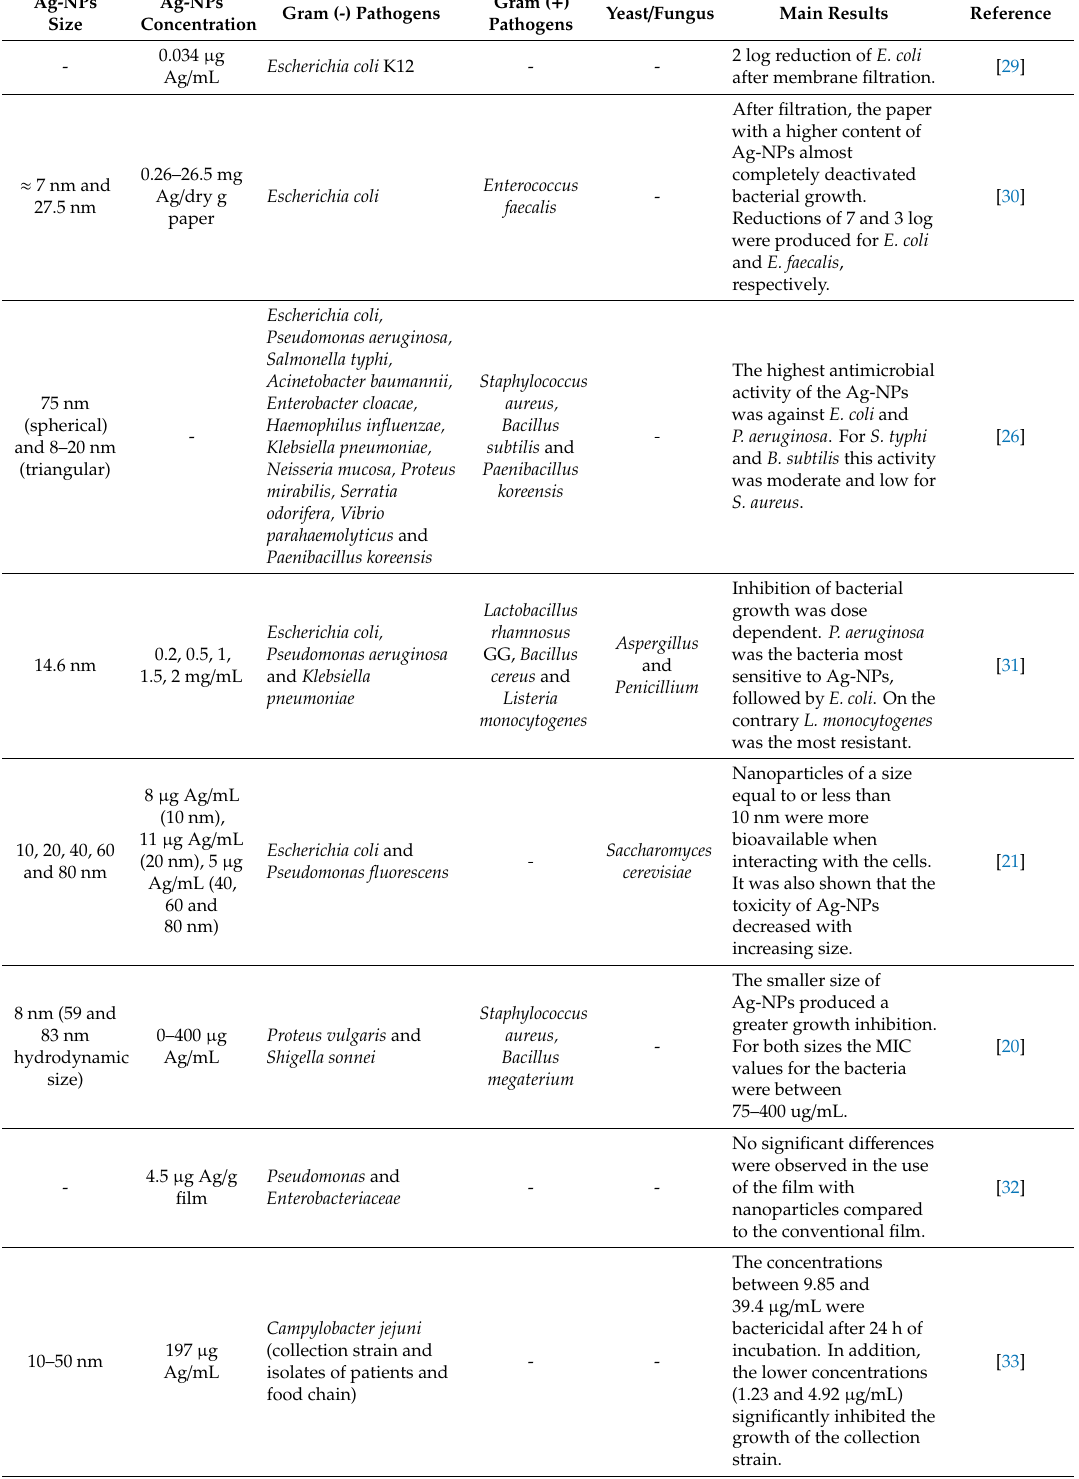
Table 1. Recompilation of studies about the antimicrobial e ff ects of Ag-NPs against foodborne pathogens. Ag-NPs